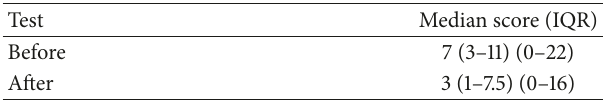
Table 3: Association of periodontal diseases OHIP-14 item score before and after NSPT #